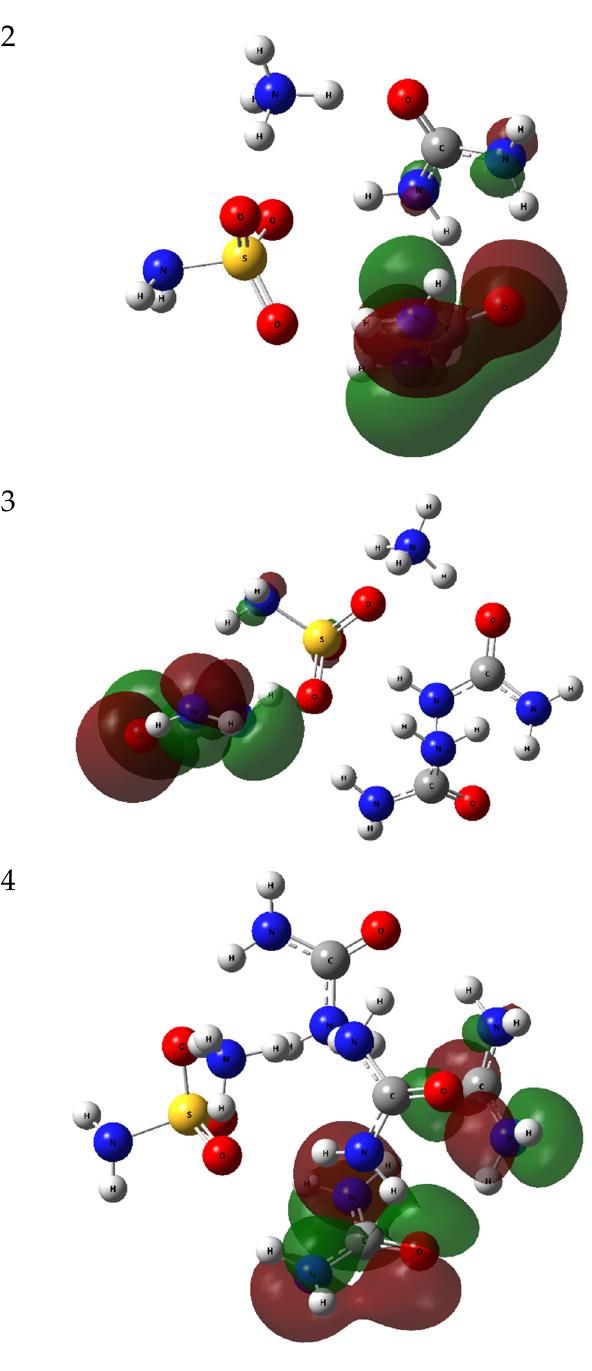
Figure 6. Frontier molecular orbitals in the ammonium sulfamate–urea system with different contents of urea molecules.